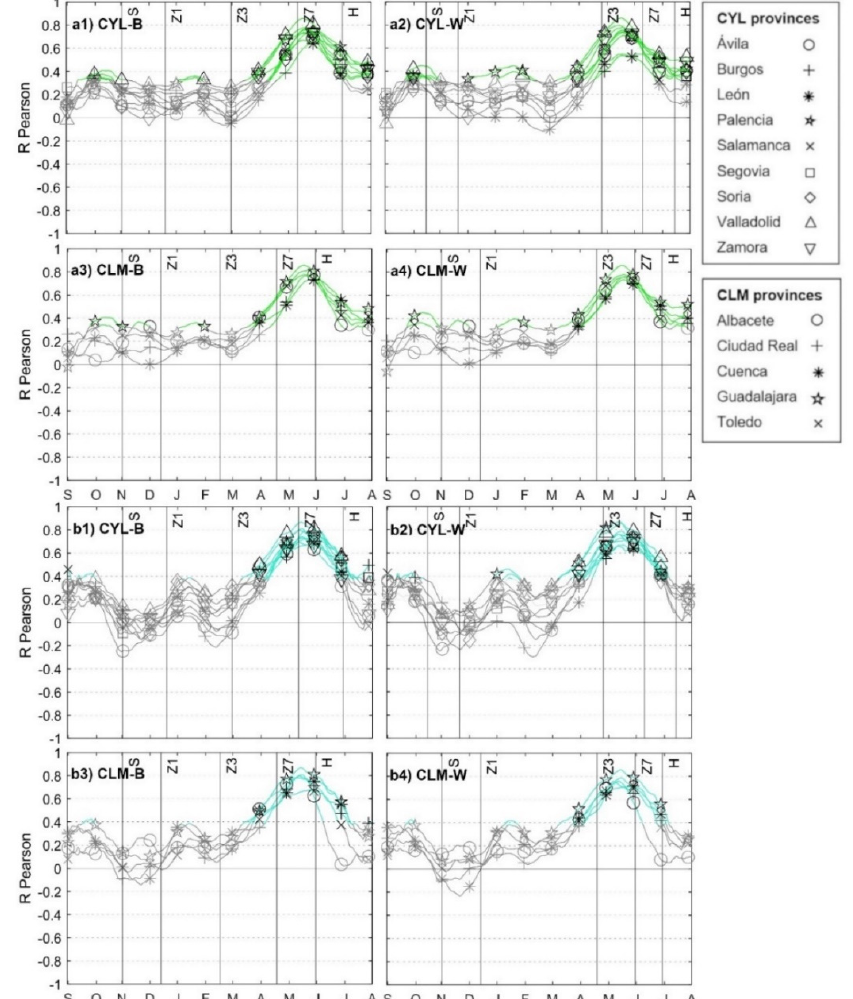
Figure 4. Daily correlations (line plots indicating the Pearson coefficient values) and periods of significance (colored line segments) of soil moisture data from ERA5-Land ( a1 – a4 ) and LISFLOOD ( b1 – b4 ) with the annual yield of barley ( a1 , a3 , b1 , b3 ) and wheat ( a2 , a4 , b2 , b4 ) during the growing season in the provinces of CYL ( a1 , a2 , b1 , b2 ) and CLM ( a3 , a4 , b3 , b4 ). The differentiated evolution of the lines along the year secondarily illustrates the spread of correlations among provinces. Shape symbols overlapping the lines label the line of each province. Months are indicated on the primary x-axis and Zadok’s stages over the vertical lines from the secondary x-axis.